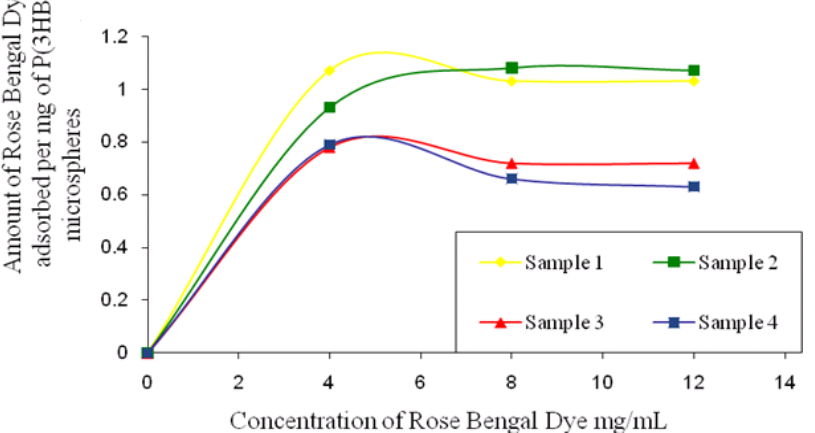
Figure 5. Amount of Rose Bengal Dye bound onto the surface of P(3HB) microspheres (sample1, sample 2, sample 3, sample 4) as a function of an increase in Rose Bengal dye